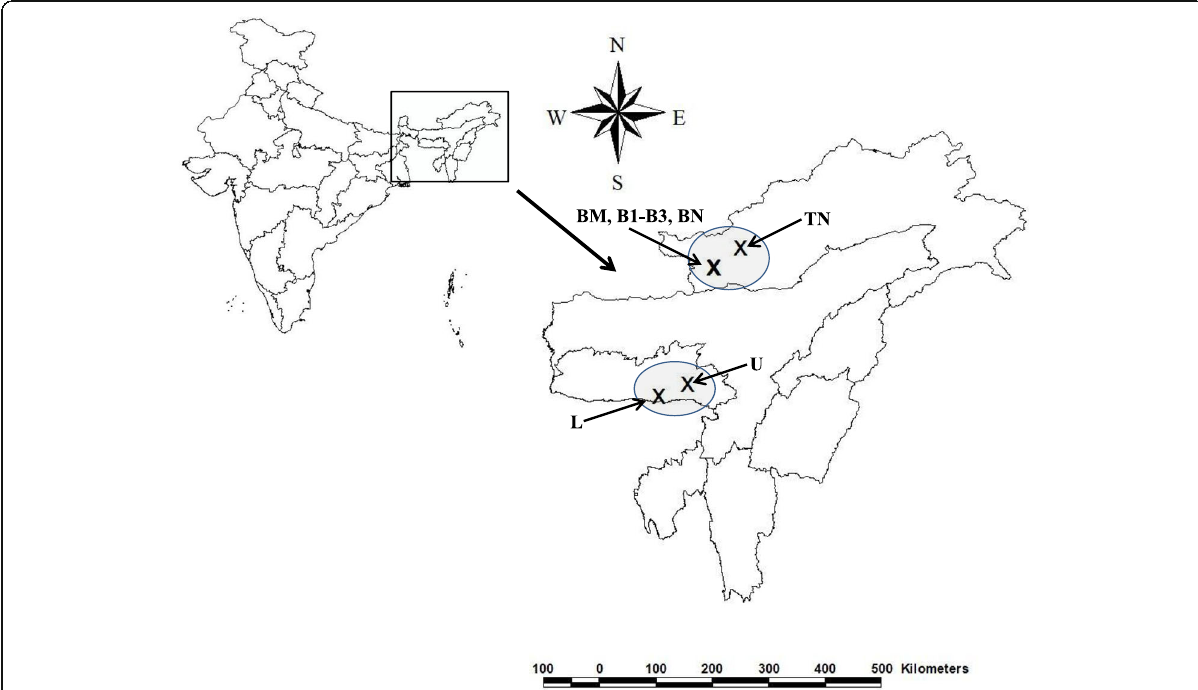
Fig. 2 Geographical distribution of collected I . griffithii genotypes from Meghalaya and Arunachal Pradesh (x represents collection